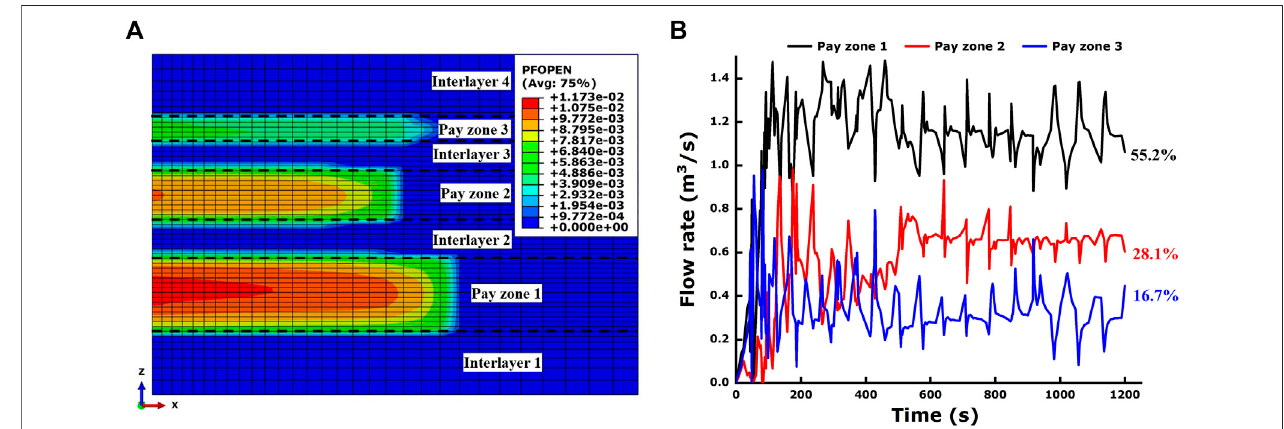
FIGURE12| Fracturegeometryand fl owratesofthe fl uidintopayzoneswithnewpayzonepermeability. (A) Hydraulicfracturegeometry; (B) Flowratesof fl uidinto the three pay zones.